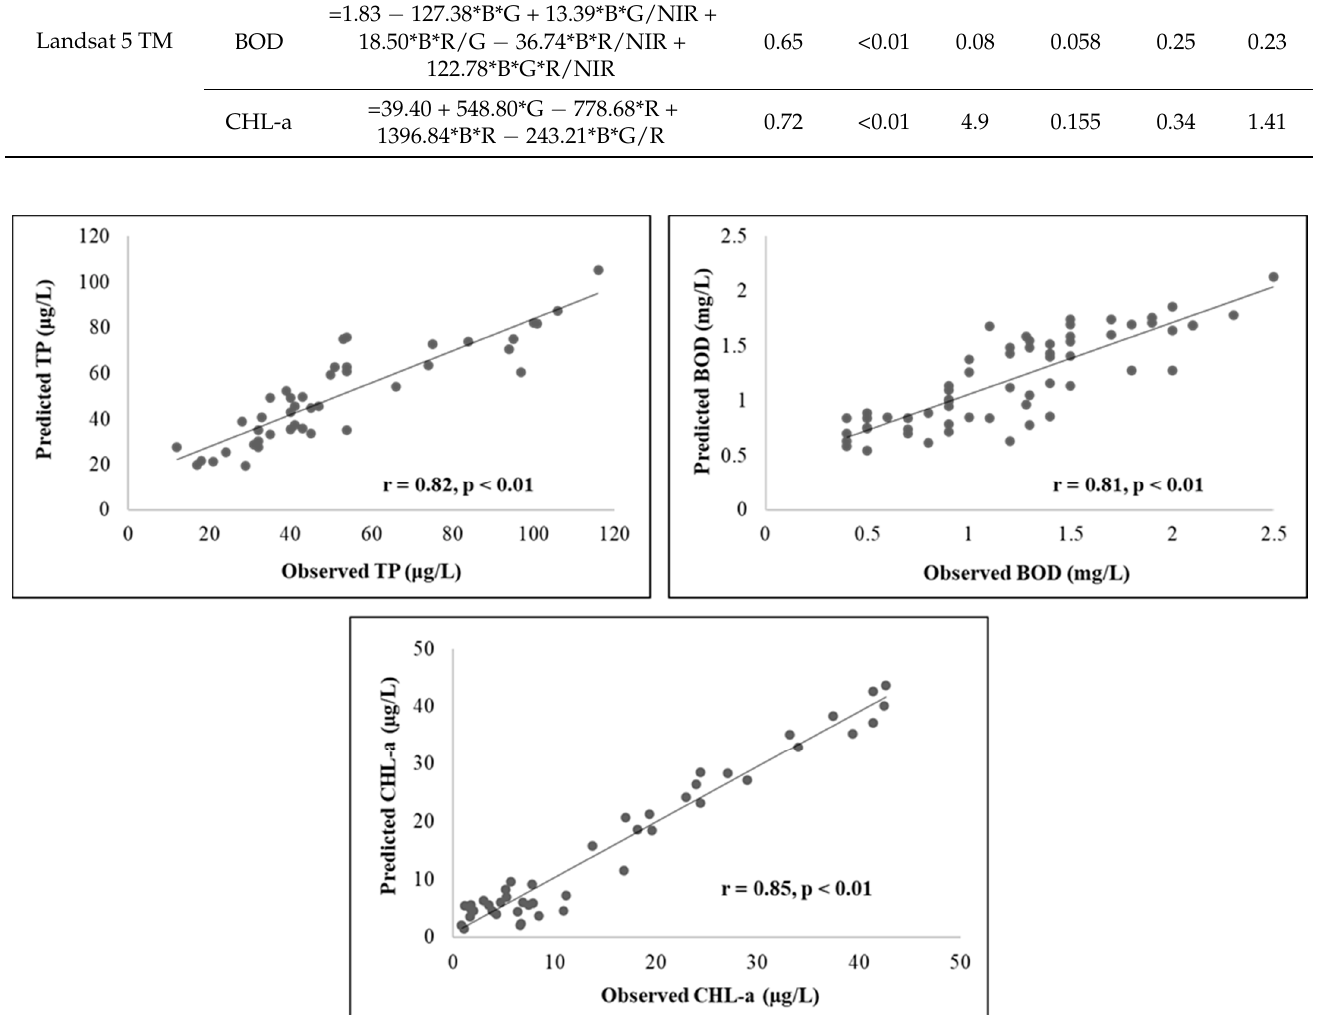
Table 4. Linear equations for Landsat 5 TM to detect TP, BOD and CHL-a of Paldang Reservoir (B: Blue, G: Green, R: Red, NIR: Near-Infrared, TP: Total Phosphorus, BOD: Biological Oxygen Demand, CHL-a: Chlorophyll-a, WQPs: Water Qual- ity Parameters).